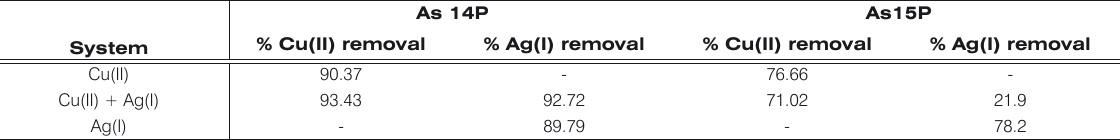
Table 4. Percentages of Cu(II) (C =100 mg L -1 ) and Ag(I) (C =10 mg L -1 ) removal in mono component and bi component system (pH=4, 0 0 T=25°C, 600 minutes contact time). As 14P System